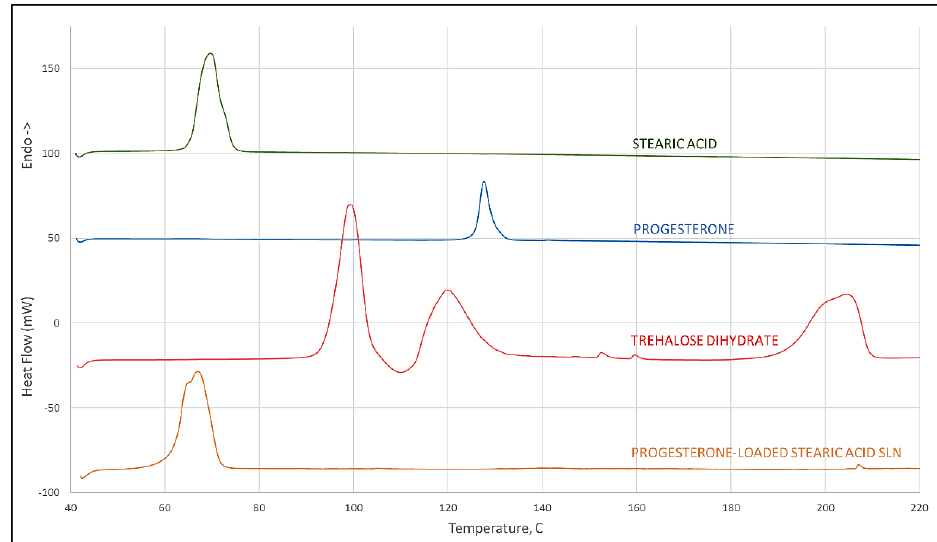
Figure 2. DSC scan of stearic acid, progesterone, trehalose dihydrate (peak at 93 ◦ C corresponds to dehydration of the dihydrate crystal, peak at 115 ◦ C to the melt of the α -anhydrate, and 190 ◦ C to melting of the β-anhydrate crystal), and progesterone-loaded stearic acid SLNs.